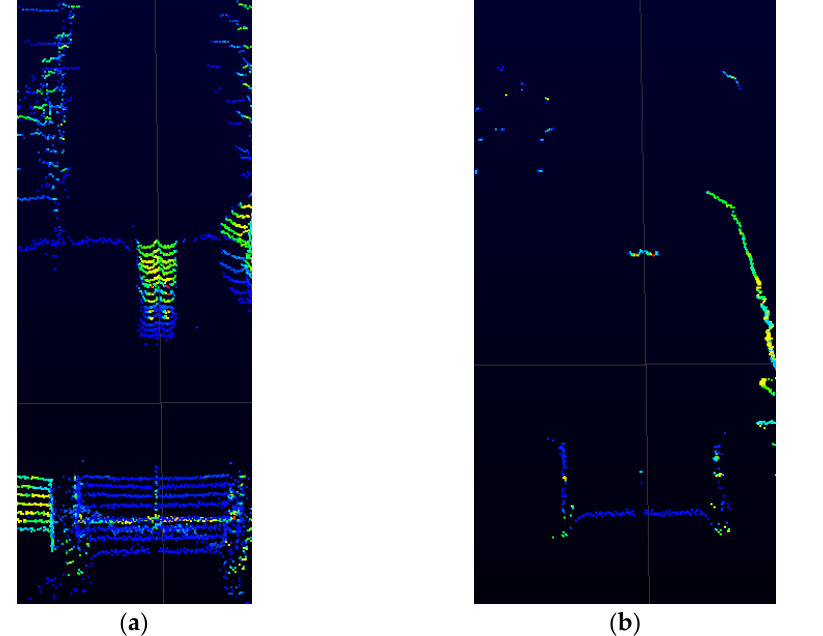
Figure 5. Zoomed view of the live-captured 3D LiDAR device: ( a ) walk path without prior ID selection (all firing laser channels); and ( b ) with only a laser ID selection of 1 (1° elevation angle).